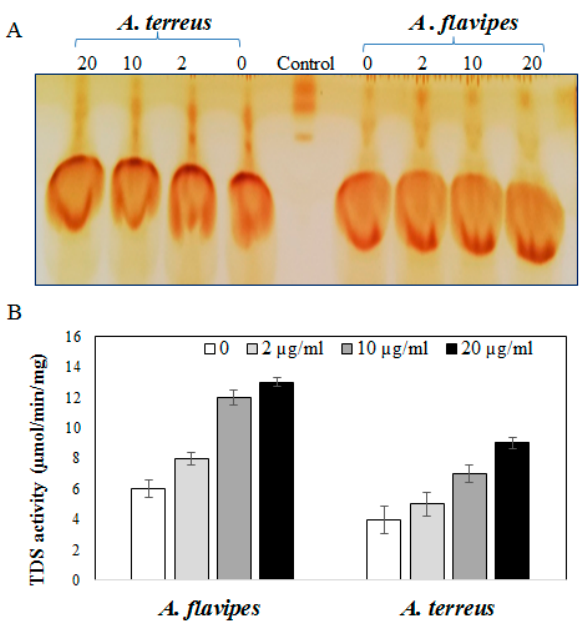
Figure 3. Activity of Taxadiene synthase by A. flavipes and A. terreus in response to fluconazole (0, 2, 10, and 20 µg/mL). ( A ) TLC chromatogram of residual geranylgeranyl pyrophosphate substrate for TDS from A. flavipes and A. terreus . ( B ) Activity of Taxadiene synthase from A. flavipes and A. terreus in response to fluconazole concentrations.